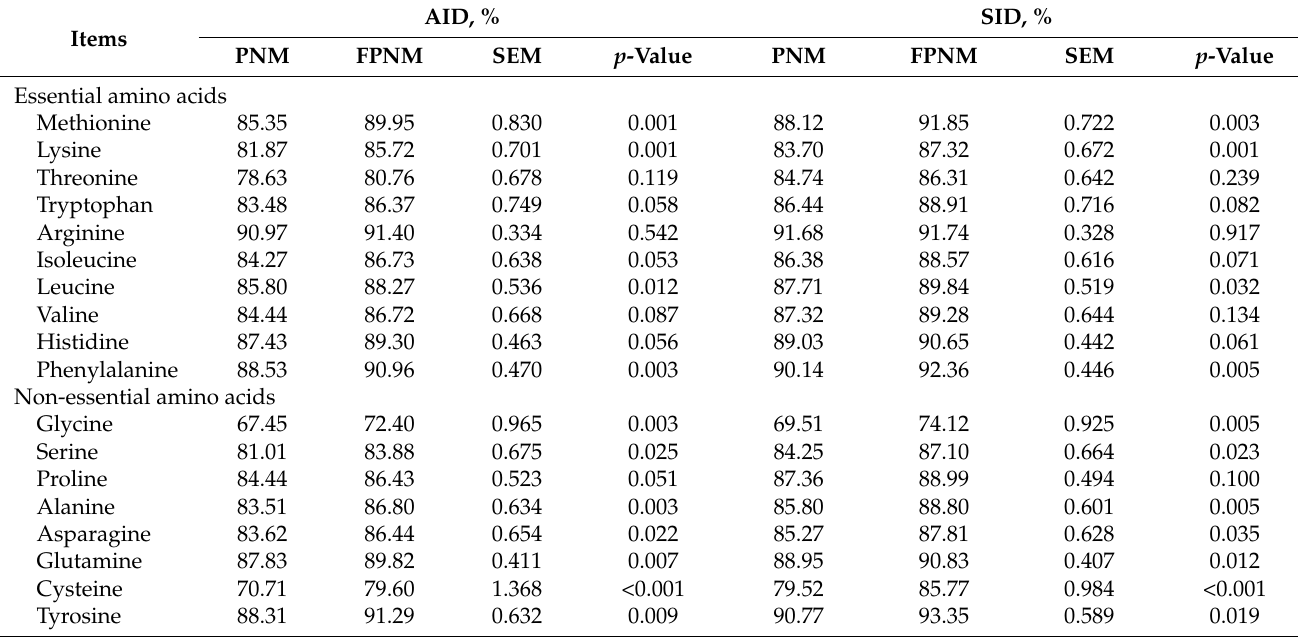
Table 6. Apparent and standardized ileal digestibility values of amino acids in PNM and FPNM (dry matter basis, n = 6) (1) .